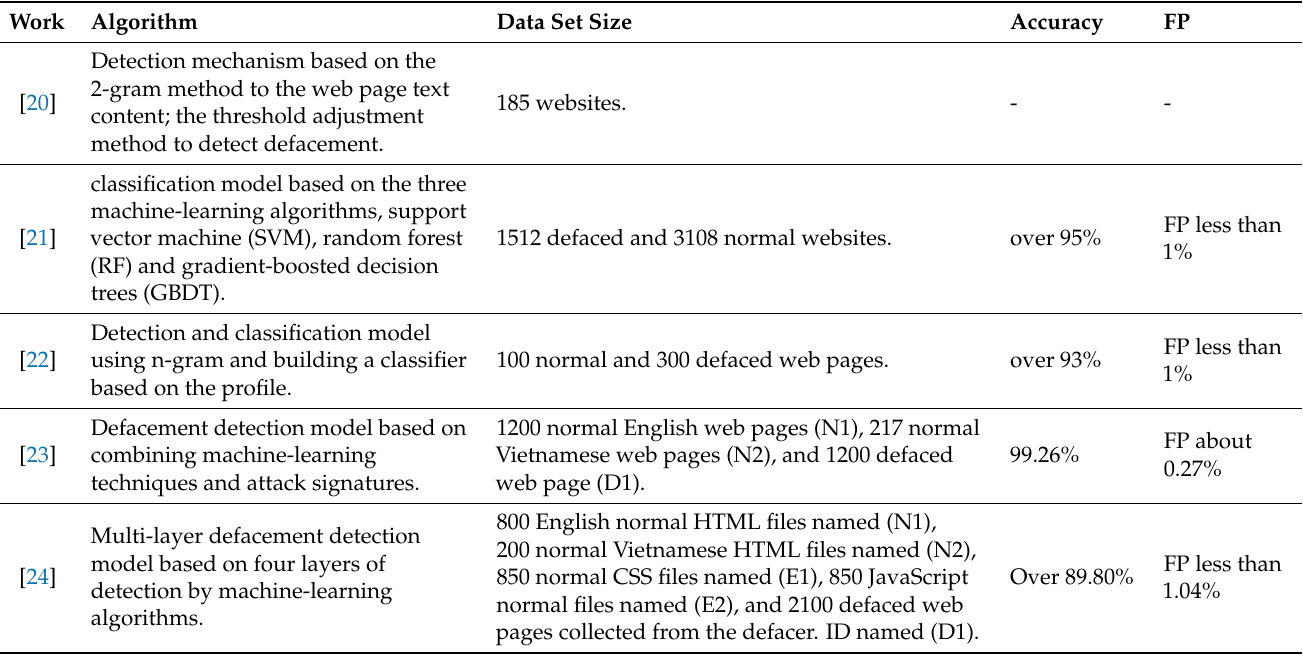
Table 1. Defacement detection based on machine-learning